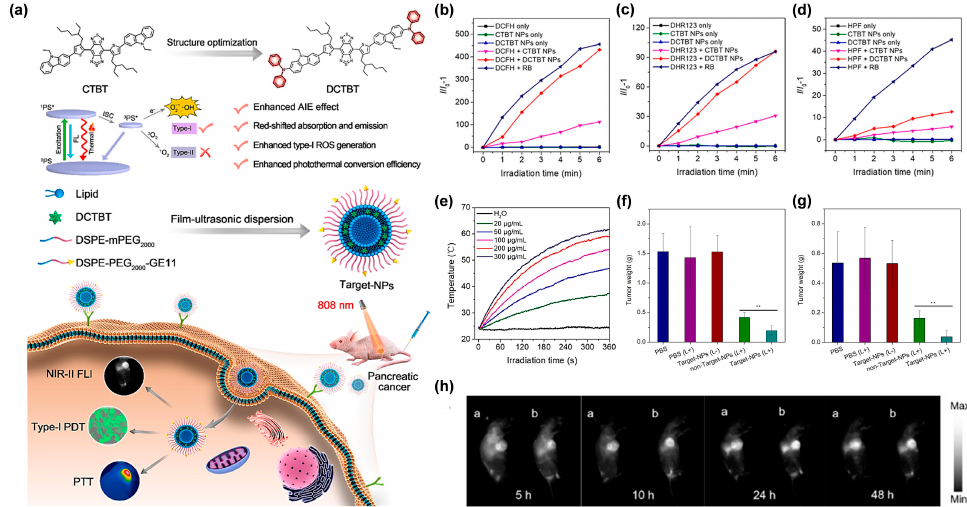
Figure 8. ( a ) Schematic illustration of molecular design and properties, as well as the preparation of target NPs and their application in NIR-II FLI-guided type I PDT-PTT pancreatic cancer therapy. Variation in PL intensity ( I / I 0 ) of ( b ) DCFH for total ROS detection, ( c ) DHR123 for O 2• − detection, and ( d ) HPF for · OH detection. ( e ) Photothermal performance of DCTBT NPs of different concen- trations upon laser irradiation (808 nm, 0.8 W/cm 2 , 6 min). ( f ) The average tumor weights of the subcutaneous PANC-1 tumor-bearing mice after different treatments recorded on day 17 (** p < 0.01). ( g ) The average tumor weights of the orthotopic PANC-1 tumor-bearing mice after different treat- ments recorded on day 16 (** p < 0.01). ( h ) In vivo NIR-II fluorescence images of subcutaneous PANC-1 tumor-bearing mice at different monitoring times after administration of lip-DCTBT NPs, a: non target NPs, b: target NPs. Reprinted with permission from [67], copyright 2022,